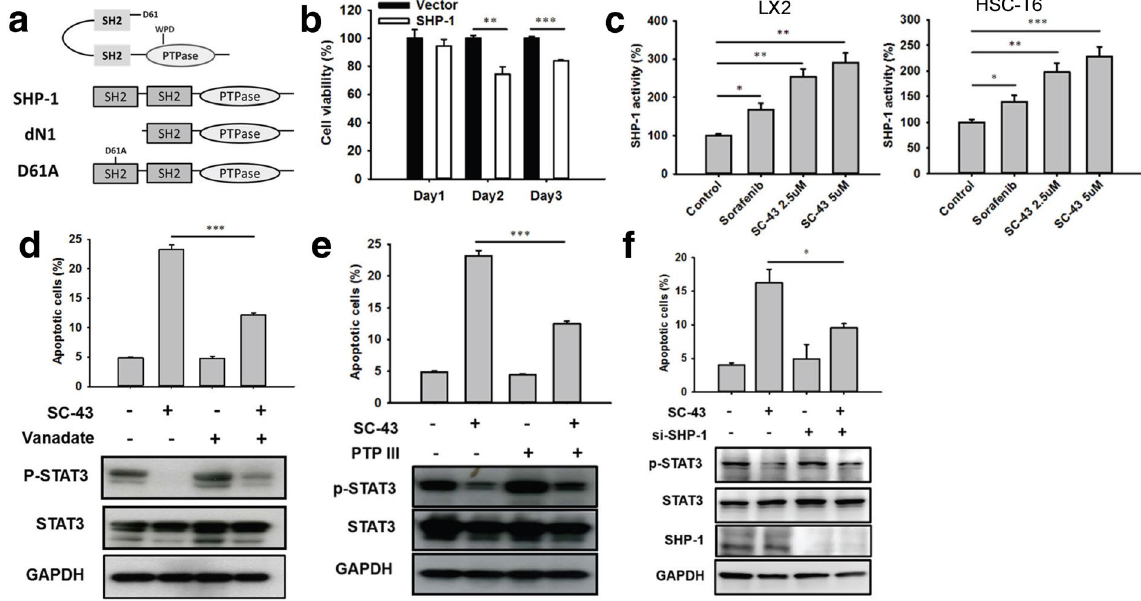
Figure 7. Association of SHP-1 with proliferation of HSCs. ( a ) SHP-1 and its mutants: dN1 (N-SH2 domain deletion) and D61A (single mutation of D61). ( b ) SHP-1 overexpression significantly reduced the LX2 cell viability. ( c ) The SHP-1 activity increased after sorafenib (5 µ M) and SC-43 (2.5 and 5 µ M) administration in both LX2 and HSC-T6 cells. ( d ) Treatment with vanadate, a nonspecific phosphatase inhibitor, upregulated p-STAT3 and reduced apoptosis. ( e ) An SHP-1-specific inhibitor (PTP inhibitor III) upregulated p-STAT3 and reduced apoptosis. ( f ) Silencing SHP-1 by using siRNA reversed the biological effects of SC-43 on p-STAT3 and apoptosis. Columns: mean and bars: standard error (n = 3–5) * P < 0.05, ** P < 0.01, and *** P <